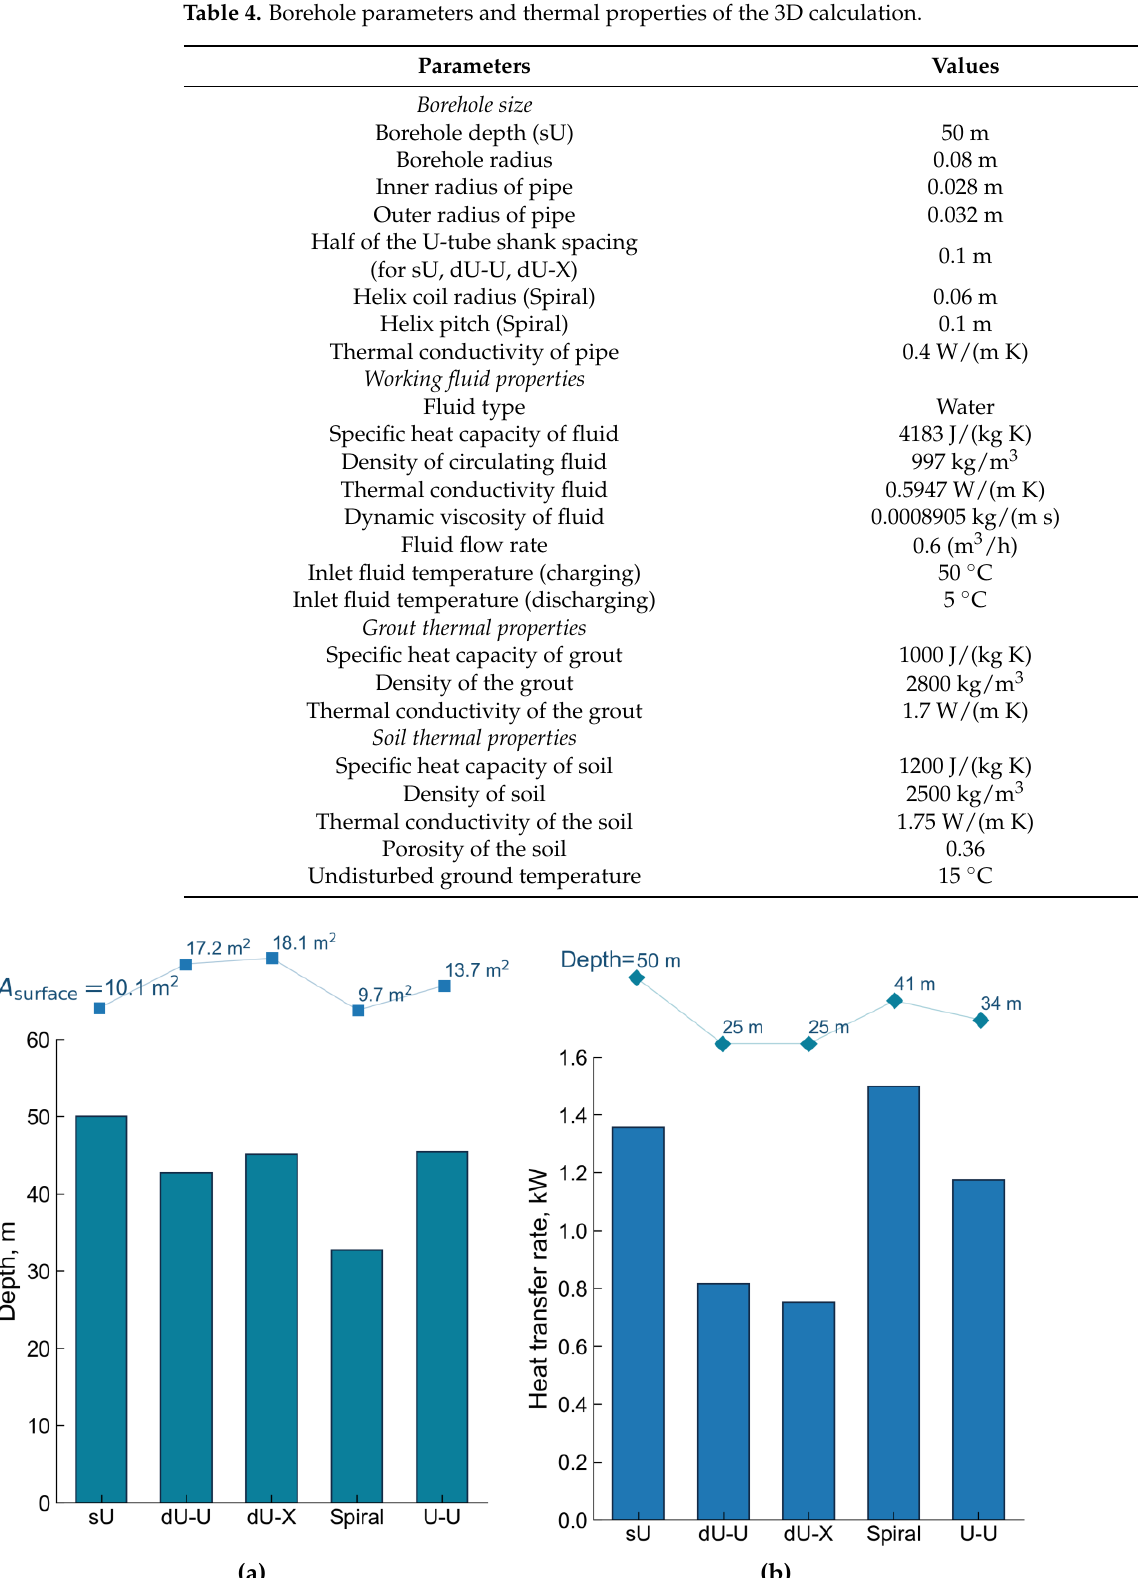
Table 4. Borehole parameters and thermal properties of the 3D calculation.